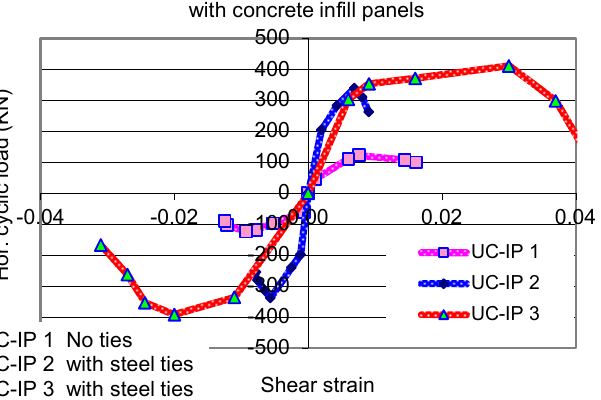
Figure 16. Horizontal load cyclic response versus sliding or separation at the contact surface of the concrete infill panel and surrounding frame for specimens UC-IP 1, UC-IP 2, and RC-IP 3.